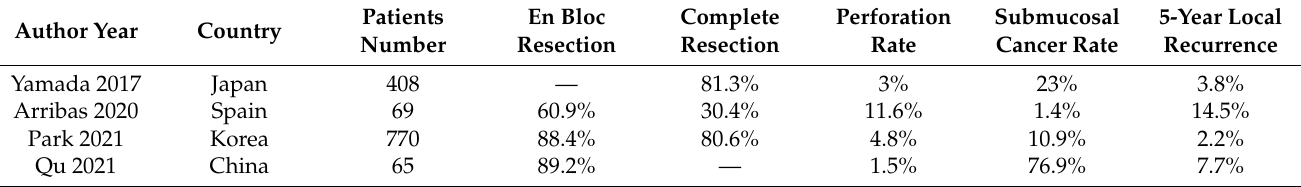
Table 2. Five-year local recurrence after colorectal endoscopic submucosal